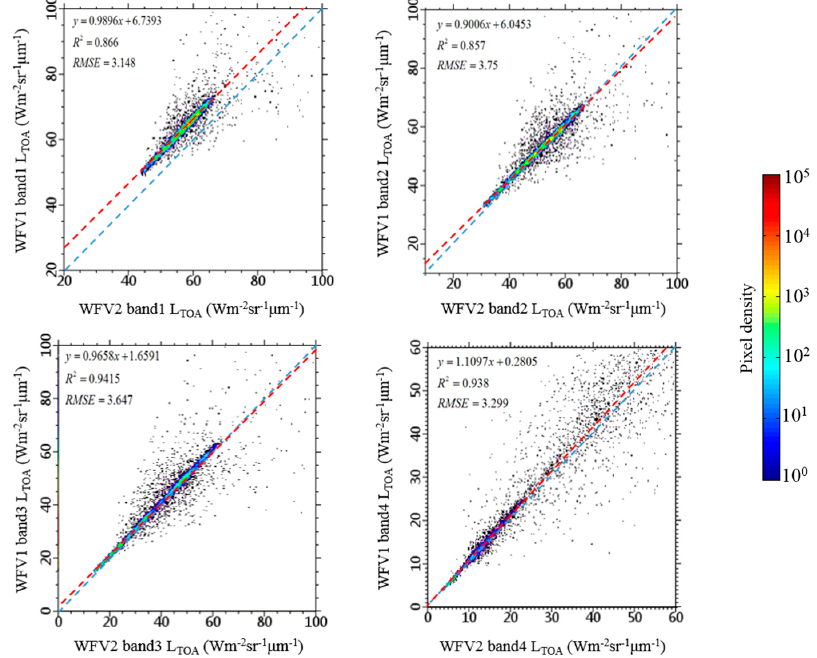
Figure 5. Comparison between WFV1 (y-axis) and WFV2 (x-axis) L TOA of corresponding pixels ( N = 4,640,117) at each band. Pixels are within two cameras’ images overlay part (dashed red box in Figure 4b). Colors denote pixel densities, the dashed red line is the regression line and the dashed blue line is the 1:1 line.